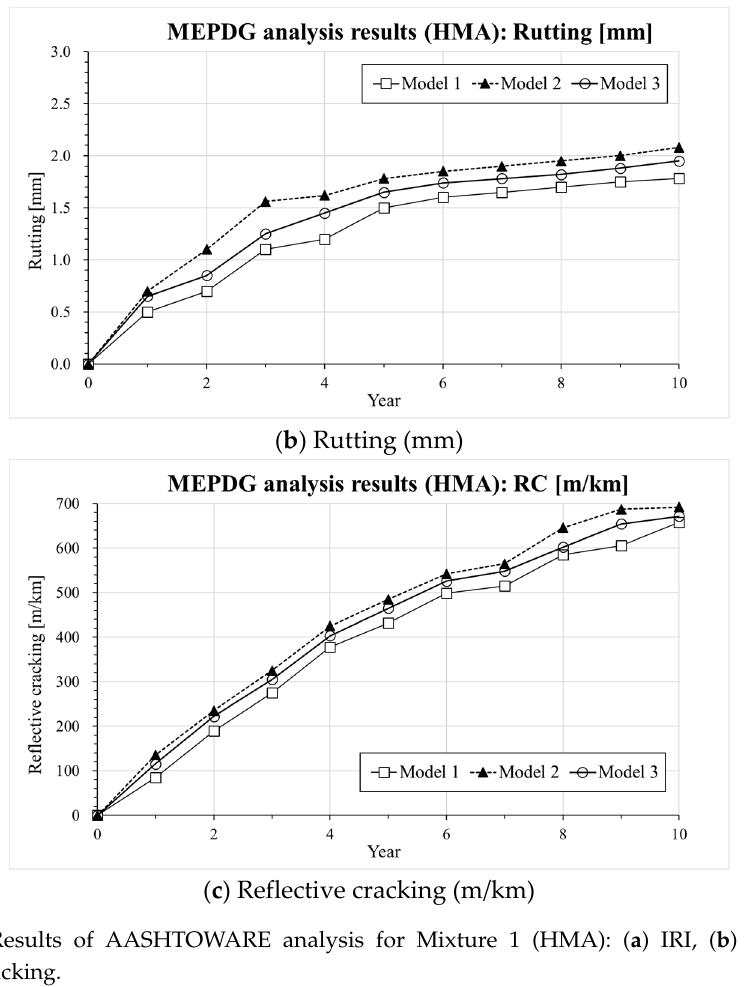
Figure 5. Results of AASHTOWARE analysis for Mixture 1 (HMA): ( a ) IRI, ( b ) Rutting, ( c ) Reflective cracking.